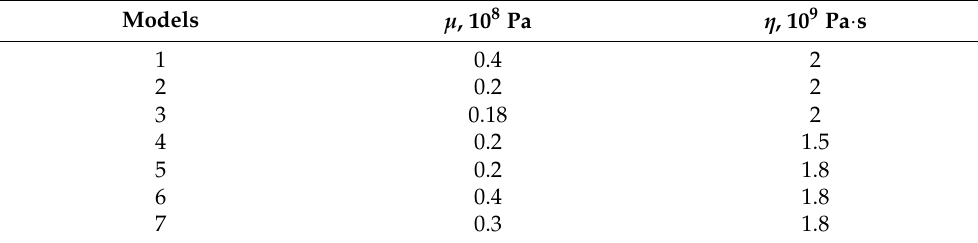
Figure 6. Disturbance amplitude as a function of distance to the rails calculated using Elsasser’s model for various ∆𝑡 ( a ) and for different sets of parameters of the Elsasser model ( b ). Model parameters are presented in Table 2. The seismometer stood 5 m from the rails. Table 2. Different sets of parameters of the railway soil elastic–viscous model.